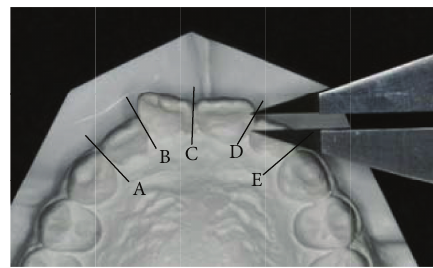
Figure 2: Irregularity index (sum of contact point displacements) (A + B + C + D + E).